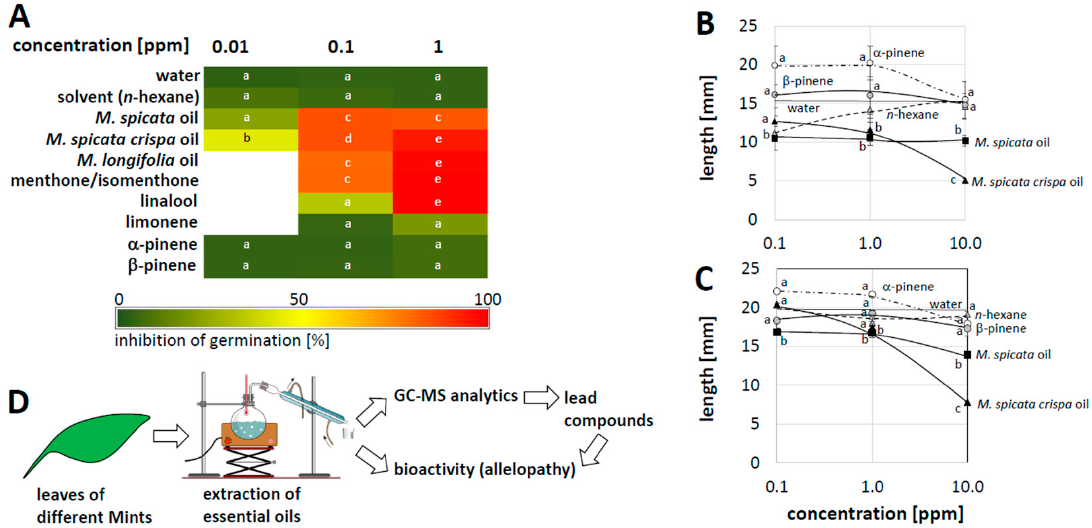
Figure 2. Response of cress seedlings to essential oils from different mints and of compounds found in these oils administered through the gas phase. ( A ) Inhibition of germination rate; mean values from five independent replications collected in two different laboratories with 100–297 individuals scored for each experiment. White fields have not been determined. ( B , C ) Modulation of seedling growth for hypocotyl ( B ) or root ( C ). Data show mean and SE over those seedlings that had germinated. Letters indicate groups that are different with respect to the Least Significant Difference (LSD) test for a significance threshold of p < 0.05. ( D ) Experimental design of the study.